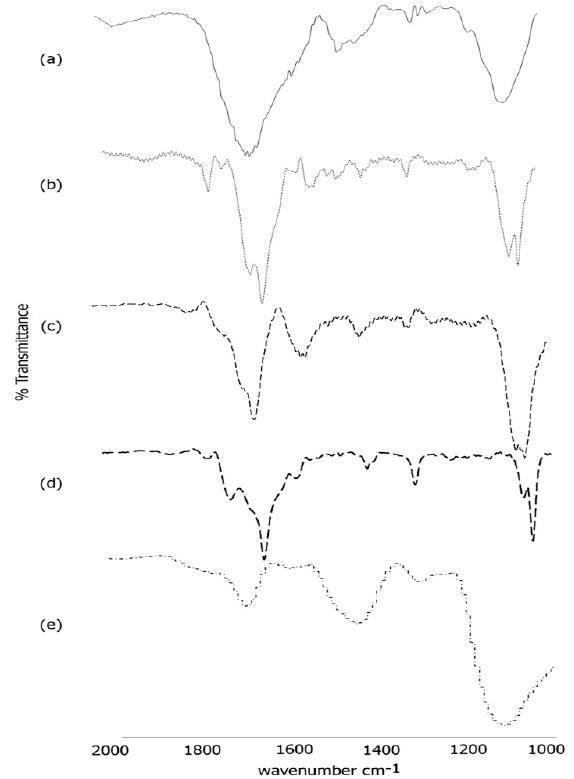
Figure 5. FTIR spectra of ( a ) self-assembled Ile-TMG-Ile nanoribbons; ( b ) Nanoribbons bound to laminin; ( c ) laminin; ( c ) Artemin conjugated with laminin bound nanoribbons; ( d ) Type IV collagen Artemin conjugated with laminin bound nanoribbons; ( d ) Type IV collagen conjugated with artemin-laminin bound nanoribbons; ( e ) PANI bound to Type IV collagen-artemin-laminin bound nanoribbons.